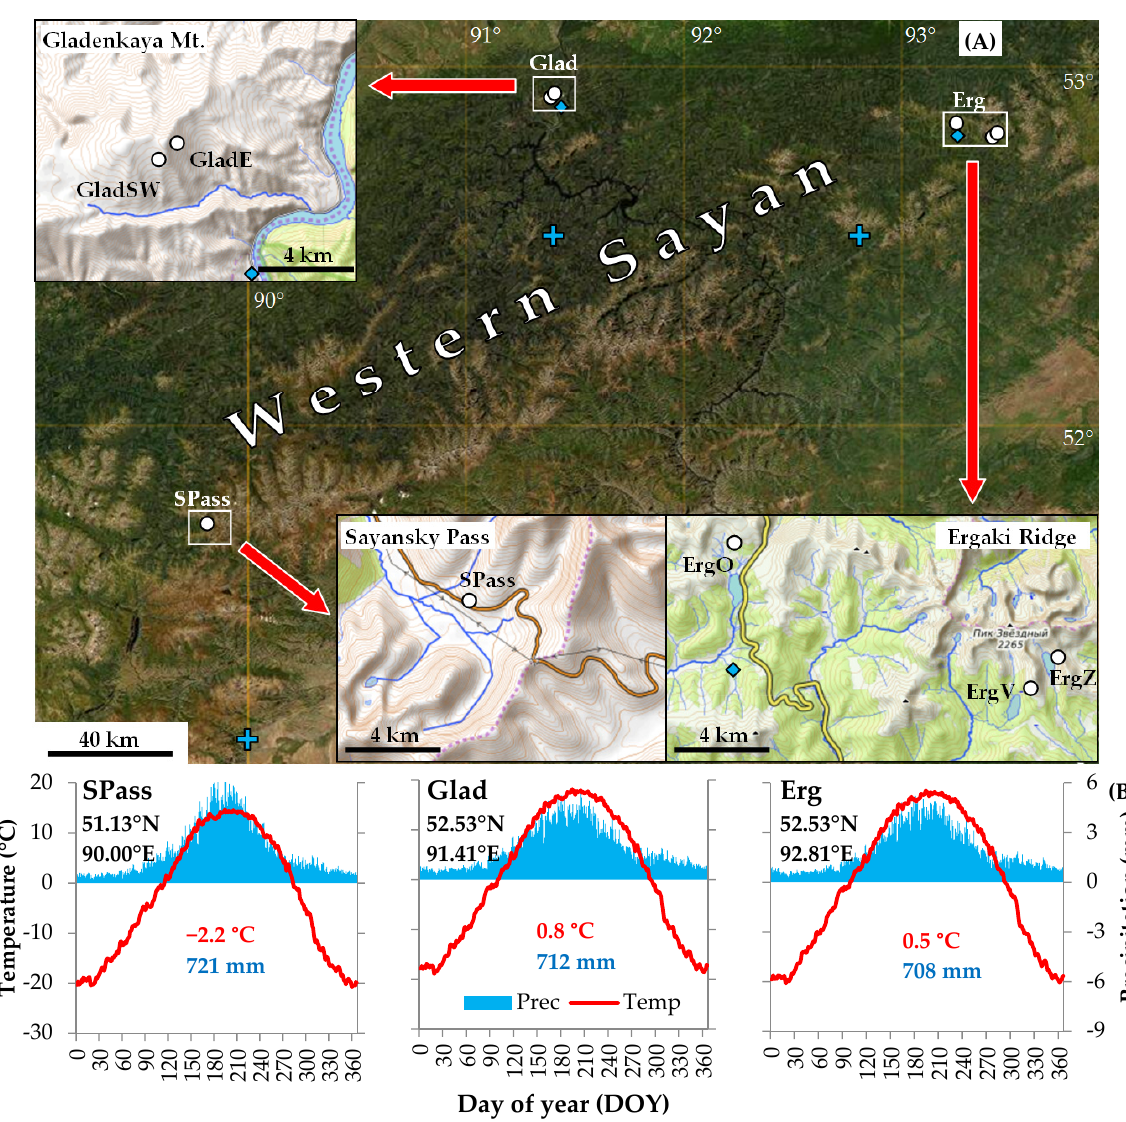
Figure 1. The study region: ( A ) satellite map (© ArcGIS) of the Western Sayan Mts. in Southern Siberia with locations of sampling sites (white circles), meteorological stations (blue diamonds), ERA-20C grid points closest to sampling sites (blue plus signs), and inserts depicting enlarged topographic maps of the study areas; ( B ) climatic diagrams of daily temperature (Temp, red lines) and precipitation (Prec, blue bars) averaged over the 1936–2010 period for the ERA-20C grid points closest to the sampling sites (coordinates are included in labels).